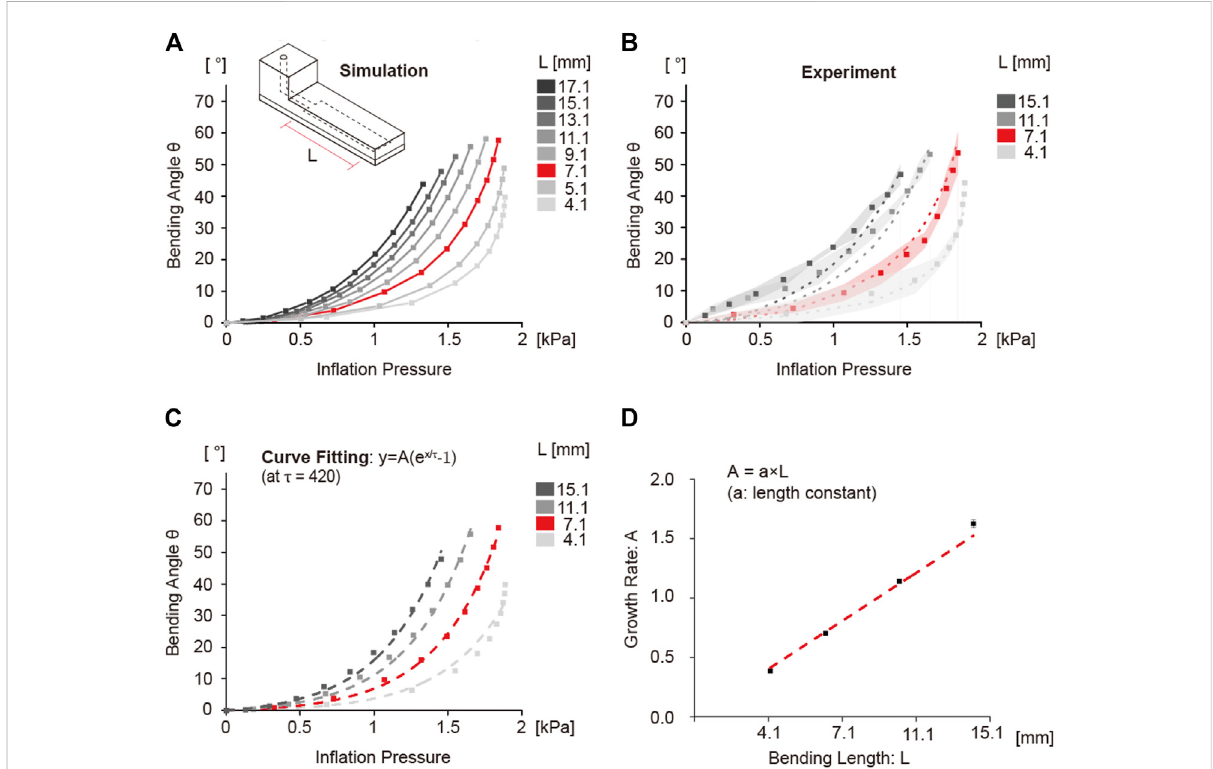
FIGURE 3 Simulationandexperimentalresultsofbendinganglechangeasafunctionofchamberlength. (A) Simulationplotshowingthebendingangleas a function of in fl ation pressure. The difference in the bending angle was con fi rmed by gradually increasing the chamber length from 4.1 to 17.1 mm. Curve for 7.1 mm shown in red was considered the standard control condition. (B) Experimental results of bending angle with 4.1, 7.1, 11.1, 15.1 mm chamber length. Dots indicate the average values of bending angle, and the shaded area represents the standard deviation of each data point. Dotted lines are the simulation results from (A) . (C) Curve fi tting analysis results using the exponential growth model. The dashed line indicates the fi tting curvegraph using estimated variables. (D) Change ofampli fi cation constant A according to change inbending length.The constant A showed a linearly increasing relationship with chamber